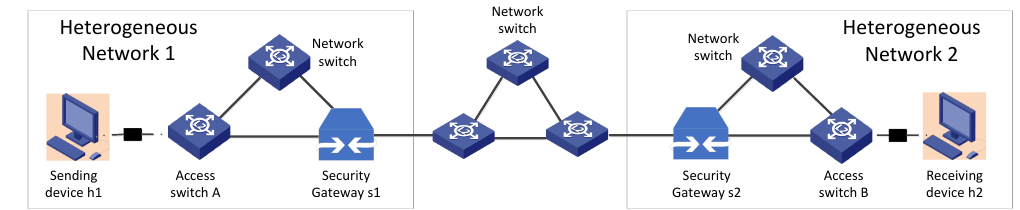
Figure 10. Evaluation testbed of